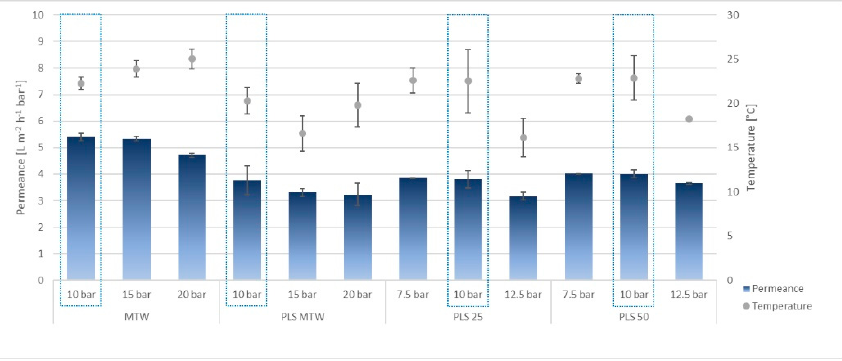
Figure 8. NF permeance for MWT, PLS MTW , PLS25, and PLS50 depending on pressure and tempera- ture.